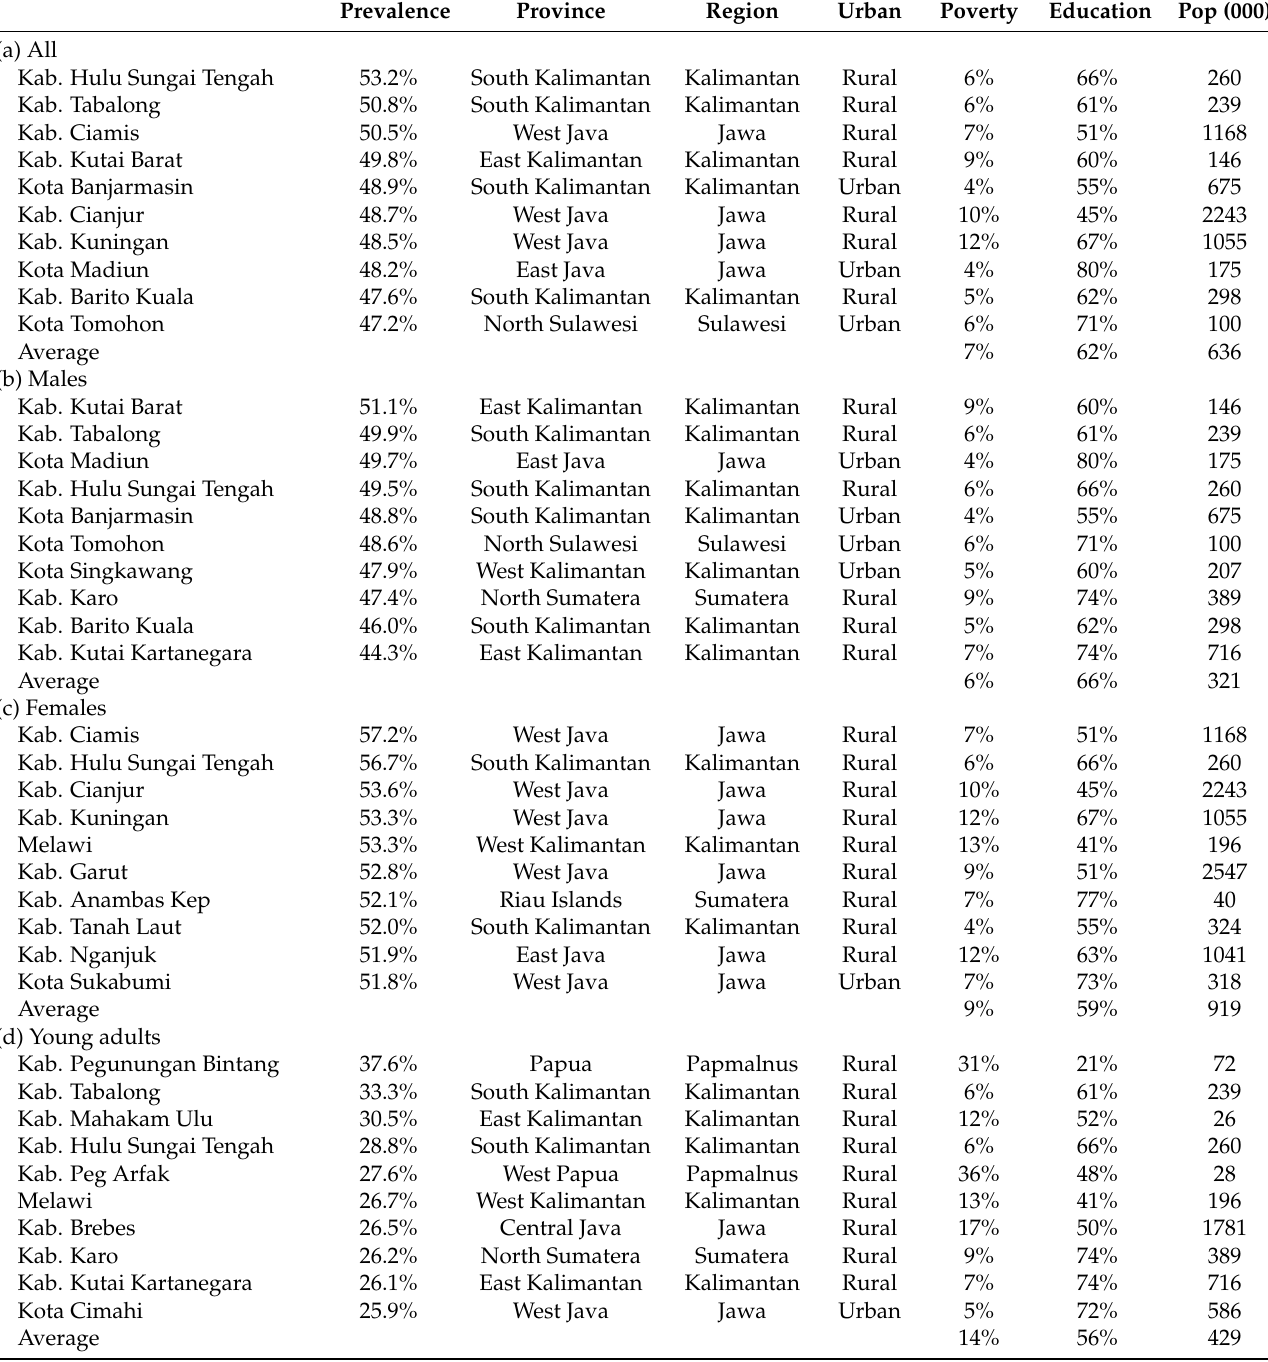
Table A3. Ten districts with the highest prevalence of hypertension among adults in Indonesia, 2018.